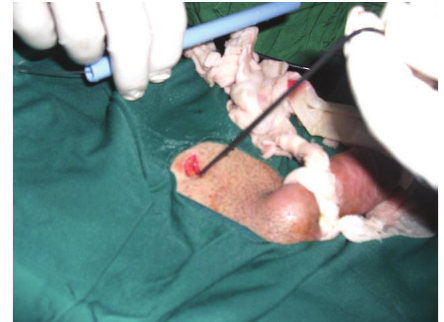
Figure 3: The ends of wire were remove from the suprapubic incision.